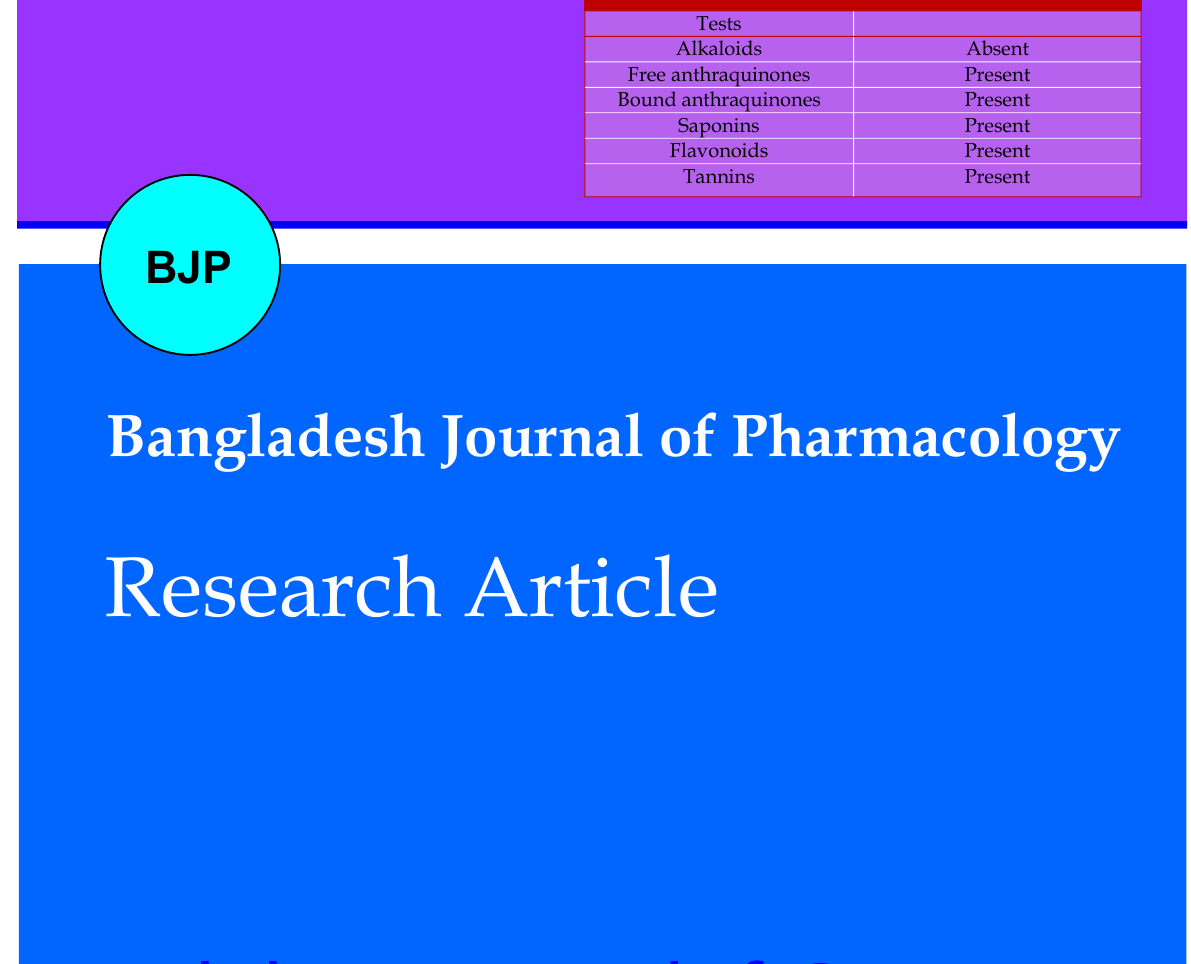
Constituents of C.